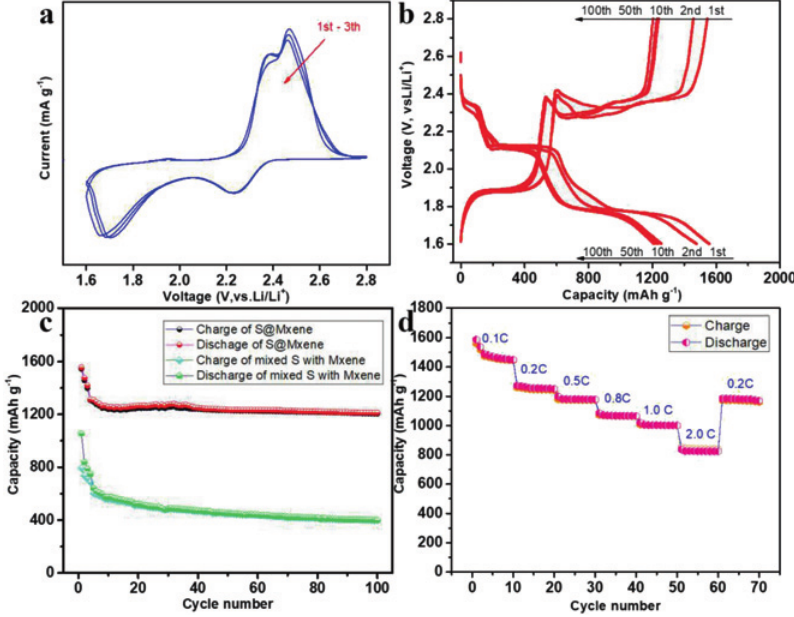
Figure 5: (a) Cyclic voltammetry (CV) of S@Mxene composite at the scan rate of 1.6 – 2.8 V at 0.1 mV/s. (b)